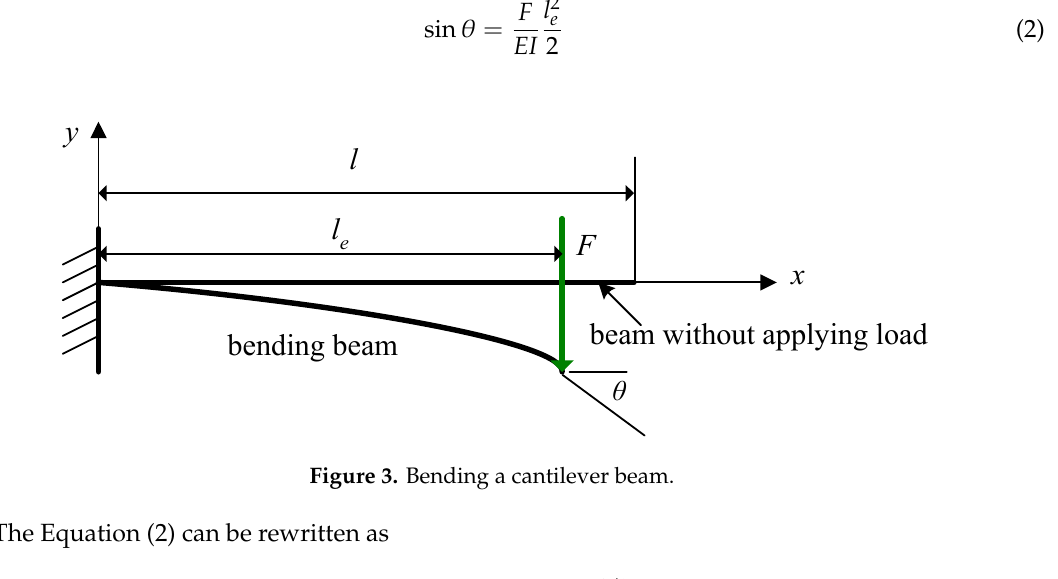
Figure 3. Bending a cantilever beam.